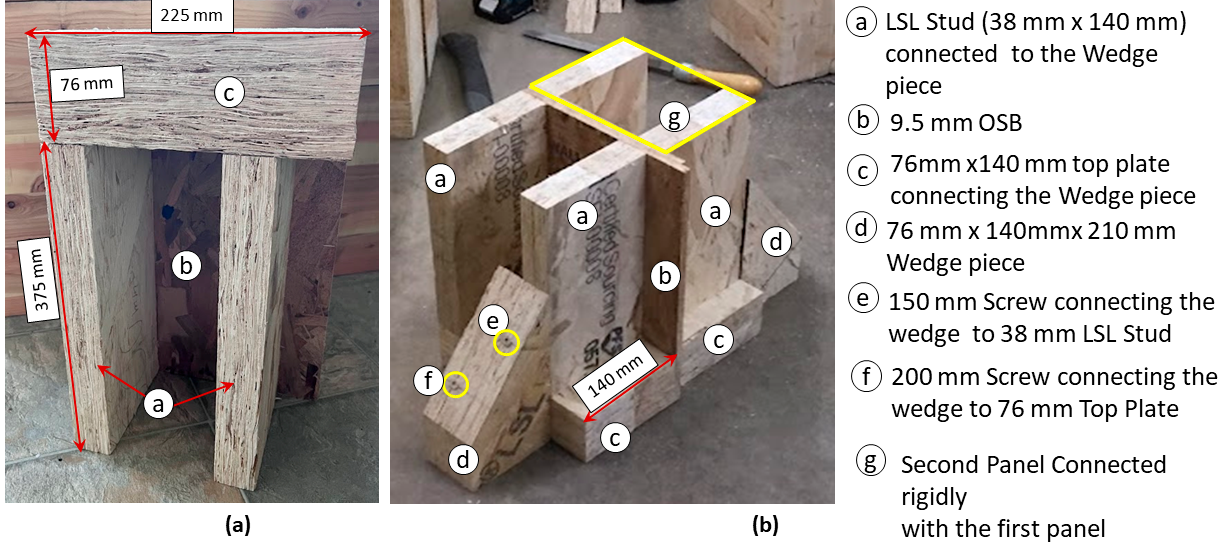
Figure 9. ( a ) 225 mm × 410 mm panel fabrication ( b ) complete Connection-B specimen.